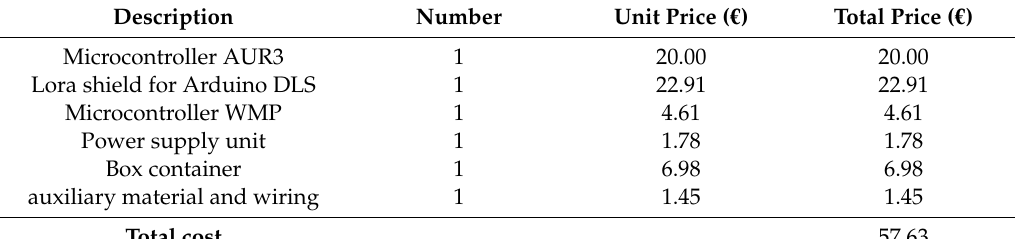
Table 3. GWLN components